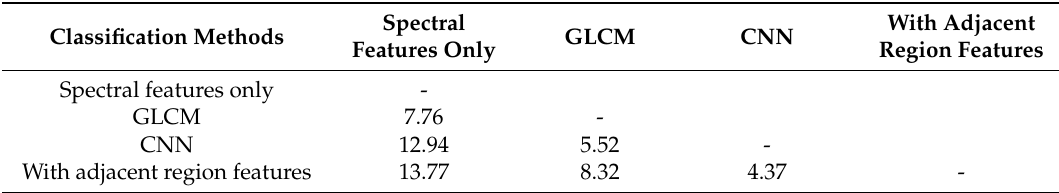
Table 4. Z-test values for comparison between confusion matrixes of LULC classification using different approaches with the best performed configurations.